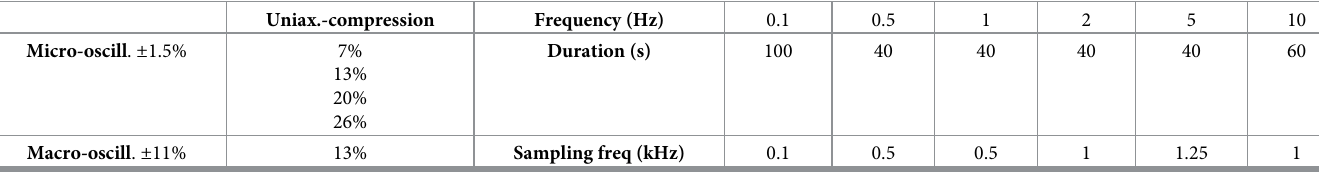
Table 1. Details of the protocol used for the rheological test. Either harmonic micro- ( * 1.5%) or macro-deformation ( * 11%) was applied on top of the uni-axial com- pression of the samples.